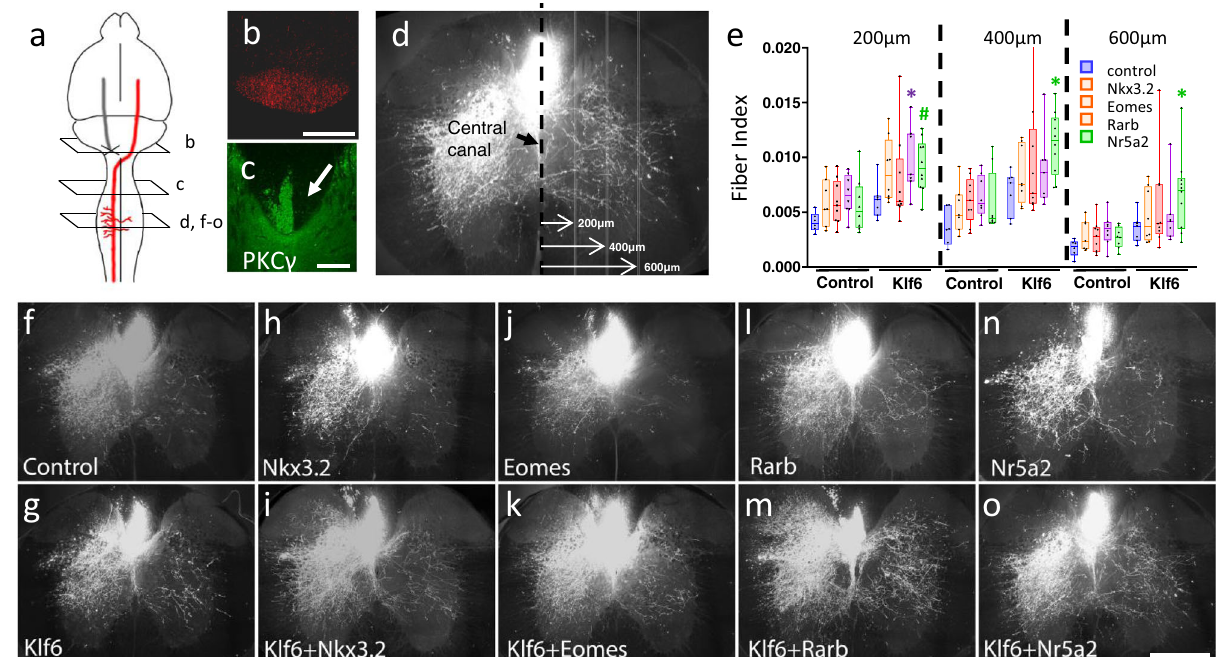
Fig. 3 Nr5a2 synergizes with Klf6 to promote CST growth. a Adult mice received cortical AAV delivery of single or combinatorial TFs and contralateral pyramidotomy. b Co-injected tdTomato-labeled CST axons, visible in cross-section of the medullary pyramids. c PKC γ immunohistochemistry con fi rmed unilateral ablation of the CST (arrow). d , e Cross-midline growth of CST axons was quanti fi ed in transverse sections of cervical spinal cord by counting intersections between labeled axons and virtual lines at 200, 400, and 600 µ m from the midline, normalized to total labeled axons counted in the medulla (Fiber Index). Candidate TFs administered singly did not signi fi cantly elevate axon growth, whereas Nr5a2 and Rarb elevated growth above the level of Klf6 alone. [# p = 0.0502, * p < 0.05 (K + R 200 µ m – 0.0284, K + N 400 µ m – 0.0129, K + N 600 µ m – 0.0367) two-way ANOVA, post hoc Dunnett ’ s]. f – o Representative images of cervical spinal cord showing elevated cross-midline growth in animals treated with Klf6 and Nr5a2. Scale bar is 500 µ m. n is between six and ten animals for all groups; PKC γ , medulla, and spinal images from all animals are in Supplementary Figs. 2 – 5. Box plots represent median and IQR (25th to 75th percentile), and whiskers extends to the maximum and minimum values. Dots in e represent values of single animals. Source data are provided as a Source data fi le. Scale bars are 200 µ m ( b , c ) and 500 µ m ( f – o